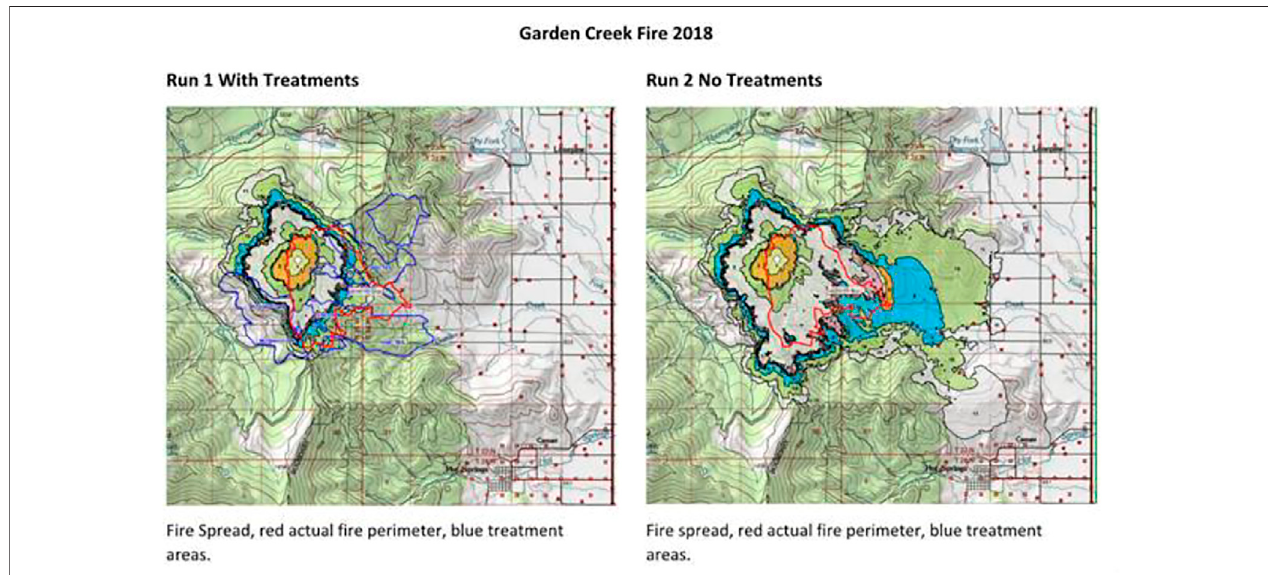
FIGURE 5 | Effect of fuel treatments on a probabilistic fi re perimeter (actual fi re shown in red) (source: analysis by Dan Mindar, National Park Service,